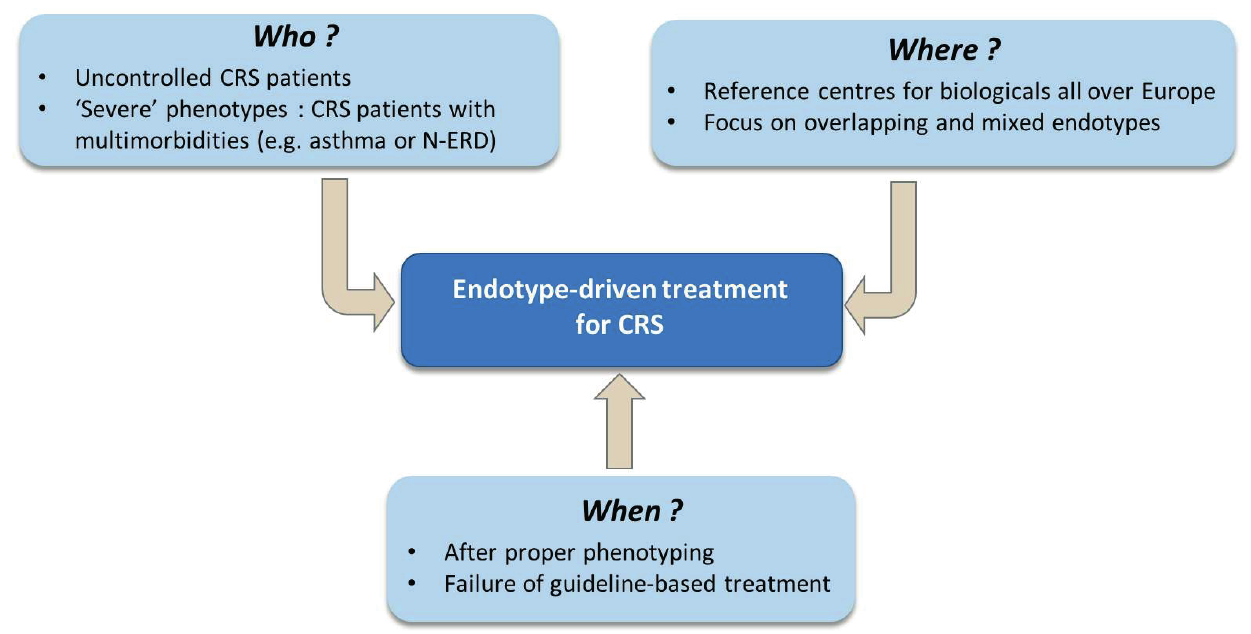
Figure 2. Obstacles and strategies for endotype-driven treatment for